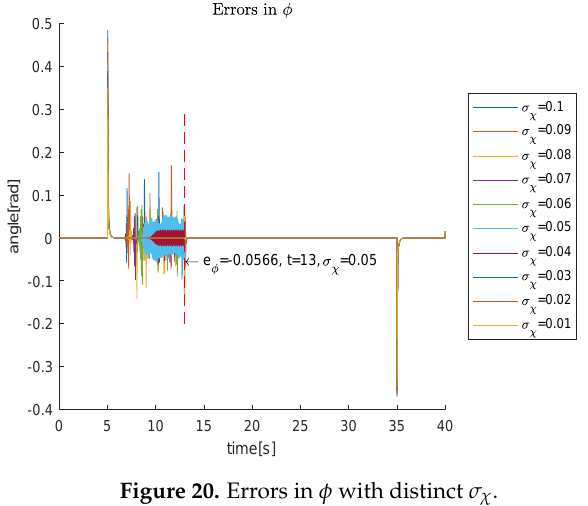
Figure 20. Errors in φ with distinct σ χ .